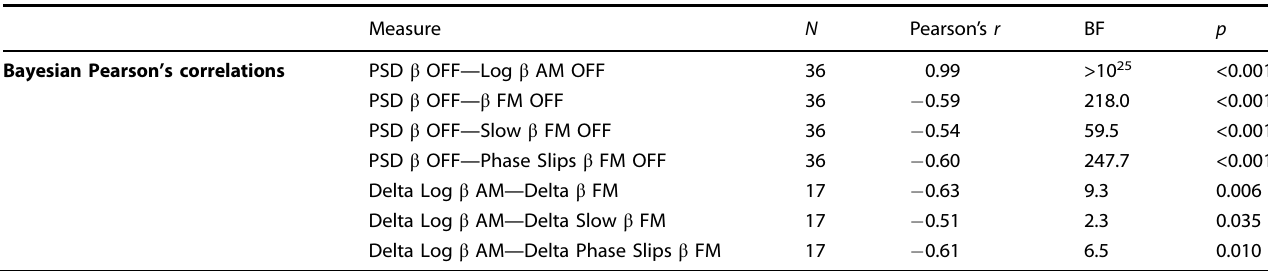
Table 3. Statistical results: